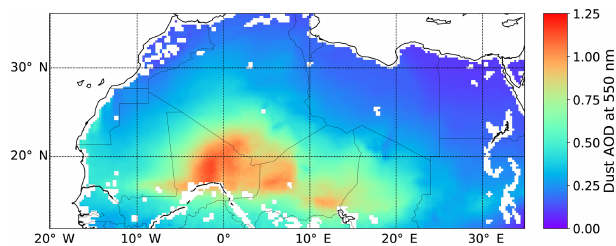
Figure 4. Map of mean dust AOD at 550nm simulated by COSMO- MUSCAT, June and July 2011–2013, for all eight time slots during the diurnal cycle. As with Fig. 2, this average is only made using points where and when RTTOV simulations have been